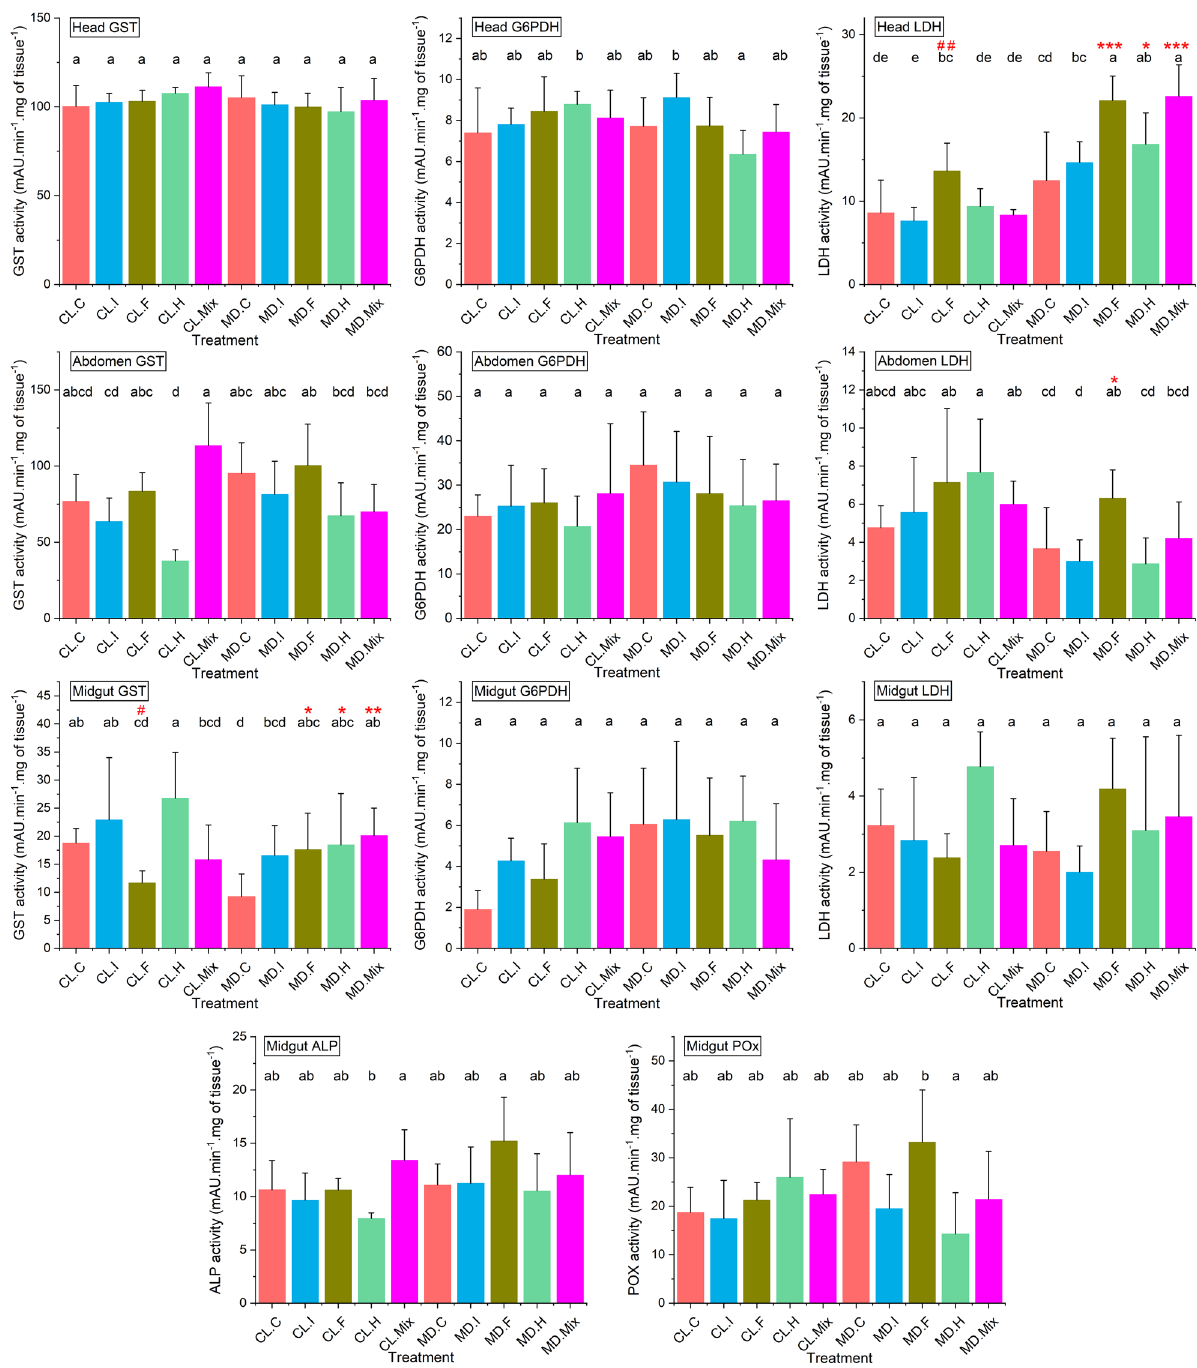
Figure 2. Physiological impacts of pesticides in colonized (CL) and microbiota-depleted (MD) honey bees. For 5 days, colonized (CL) and microbiota-depleted (MD) newly emerged honey bees were fed sucrose solutions containing no pesticides (C, Control), imidacloprid (I, Insecticide), glyphosate (H, Herbicide), difenoconazole (F, Fungicide) or the ternary mixture of these pesticides (Mix) at the concentration of 0.1 µg/L in food. The impact of the exposure to pesticides on the physiology of the surviving honey bees at day five was investigated through an analysis of three common markers in the head, abdomen and midgut (GST, G6PDH and LDH) and two specific markers in the midgut (ALP and POx). ANOVA or Kruskal–Wallis tests were applied to detect significant differences between treatments. Treatments with different letters are significantly different ( p < 0.05). # indicates a significant difference in the marker levels between colonized honey bees exposed to pesticides and their colonized control (CL.C). * and # indicate a significant difference in the marker levels between microbiota- depleted honey bees exposed to pesticides and their control (MD.C) (* or #: p ≤ 0.05; ** or ##: p ≤ 0.01; *** or ###: p ≤